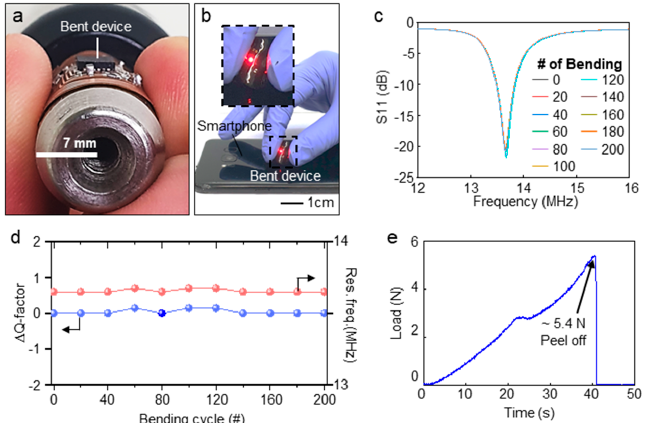
Figure 5. Frequency characteristics and bending test for wireless sensor. ( a ) Photograph image of bent device with RoC of 7 mm. ( b ) Picture of operating device in bent state. ( c ) S11 data of device measured by vector network analyzer (VNA) with cyclic bending stress. ( d ) Variation in Q-factor and resonance frequency of device in cyclic bending stress. ( e ) Peeling of test for evaluation device adhesion with skin.